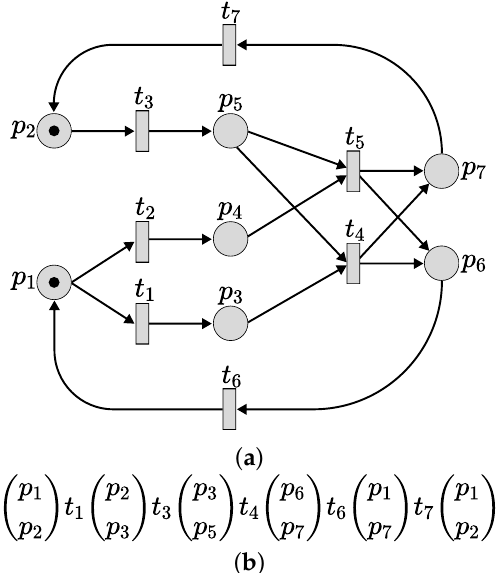
Figure 1. Self-explanatory example of net system mechanics. ( a ) A simple net system. ( b ) An occur- rence sequence of the net system in ( a